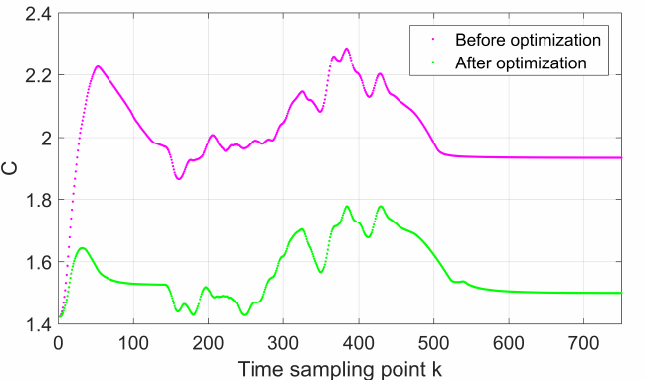
Figure 10. Aggregation coefficient of cluster 1 before and after optimization. The magenta dots and green dots respectively represent the clustering coefficients at each sampling point before and after